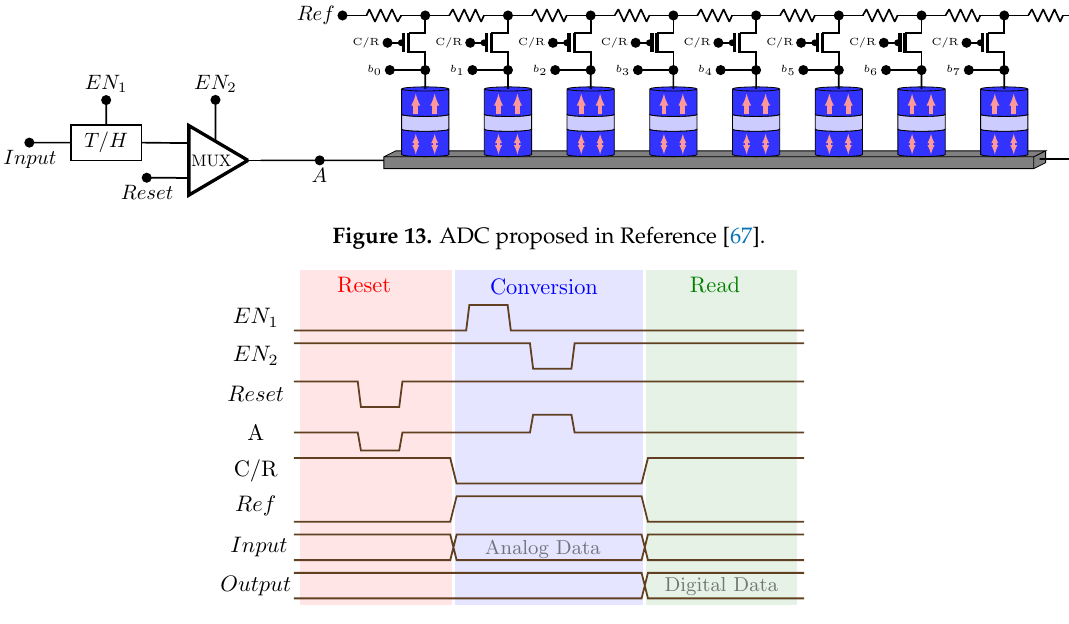
Figure 14. Timing diagram of the ADC operations [67].